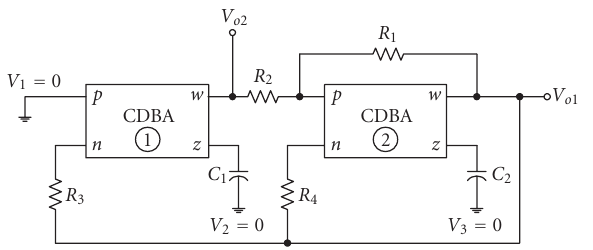
Figure 4: Proposed CDBA-based sinusoidal quadrature oscillator.